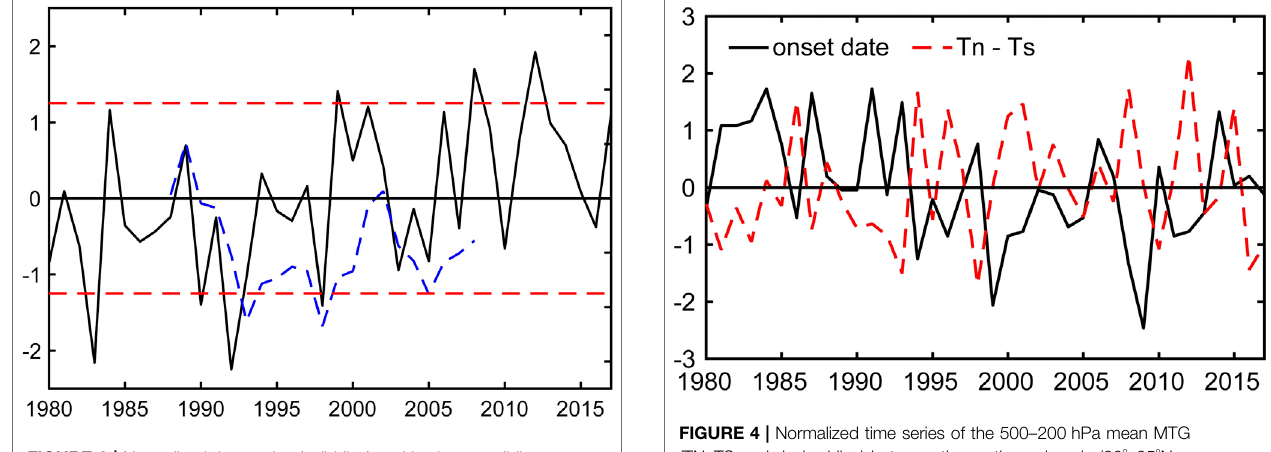
FIGURE 3 | Normalized time series (solid line) and its 9 years sliding t-test (blue dashed line) of 500 – 200 hPa mean temperature averaged in the winter center (25 ° − 32.5 ° N, 100 ° − 120 ° E) shown in Figure 1C . The red dashed lines denote the 90% con fi dence level of t